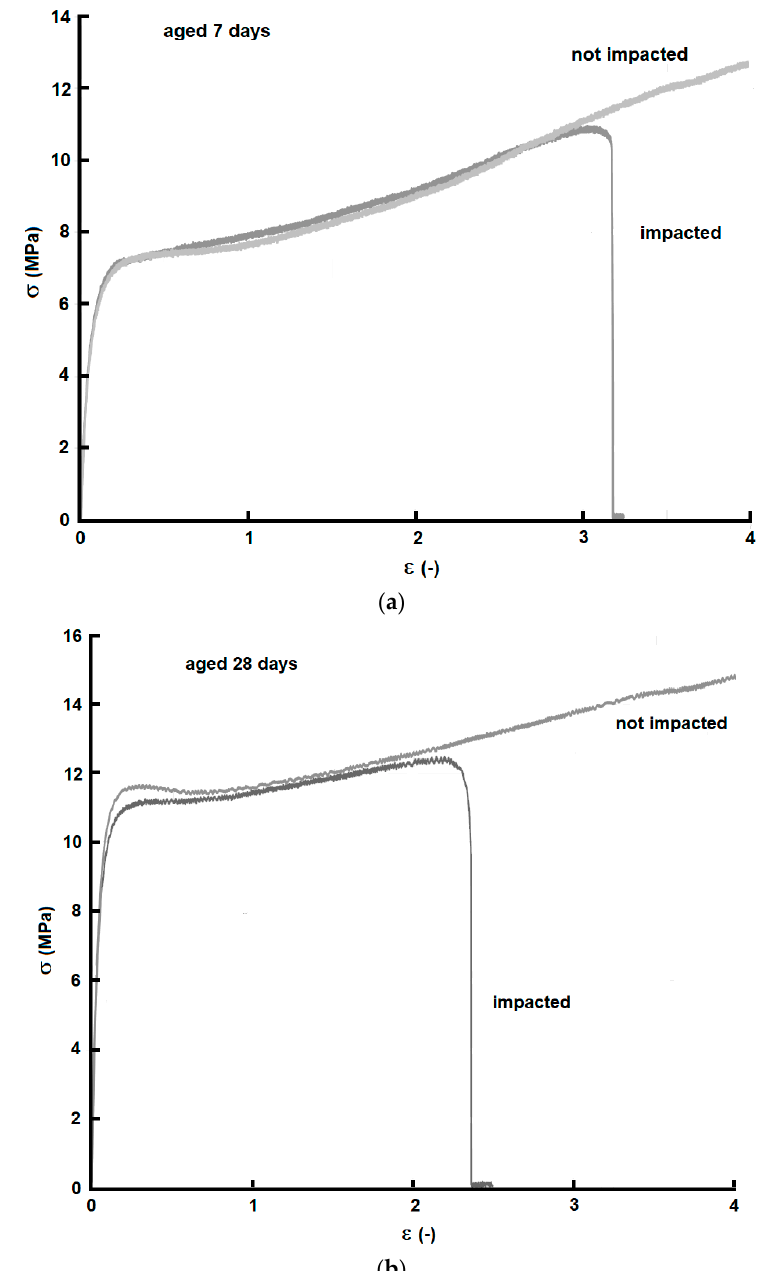
Figure 7. Stress–strain curves collected from specimens aged 7 days ( a ) and 28 days ( b ) before the impact.